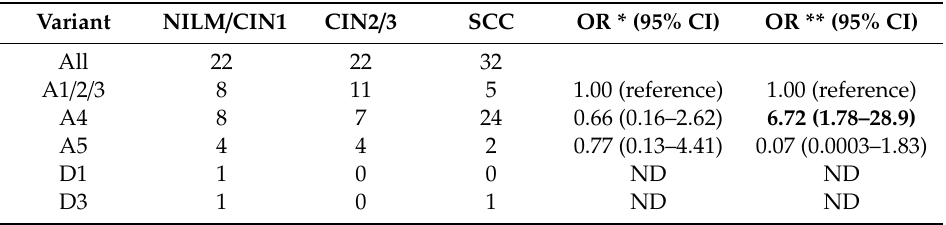
Table 2. Distribution of HPV16 variants in single-infection cases ( n =